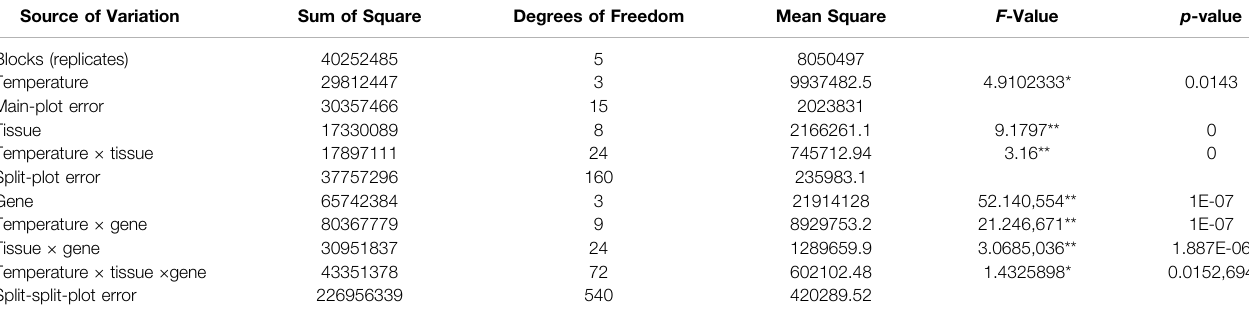
TABLE 3 | Split-split-plot analysis of variance for T. rubripes cold resistant experiment with four cold resistant genes, four temperature gradients and nine tissues. Source of Variation Sum of Square Degrees of Freedom Blocks